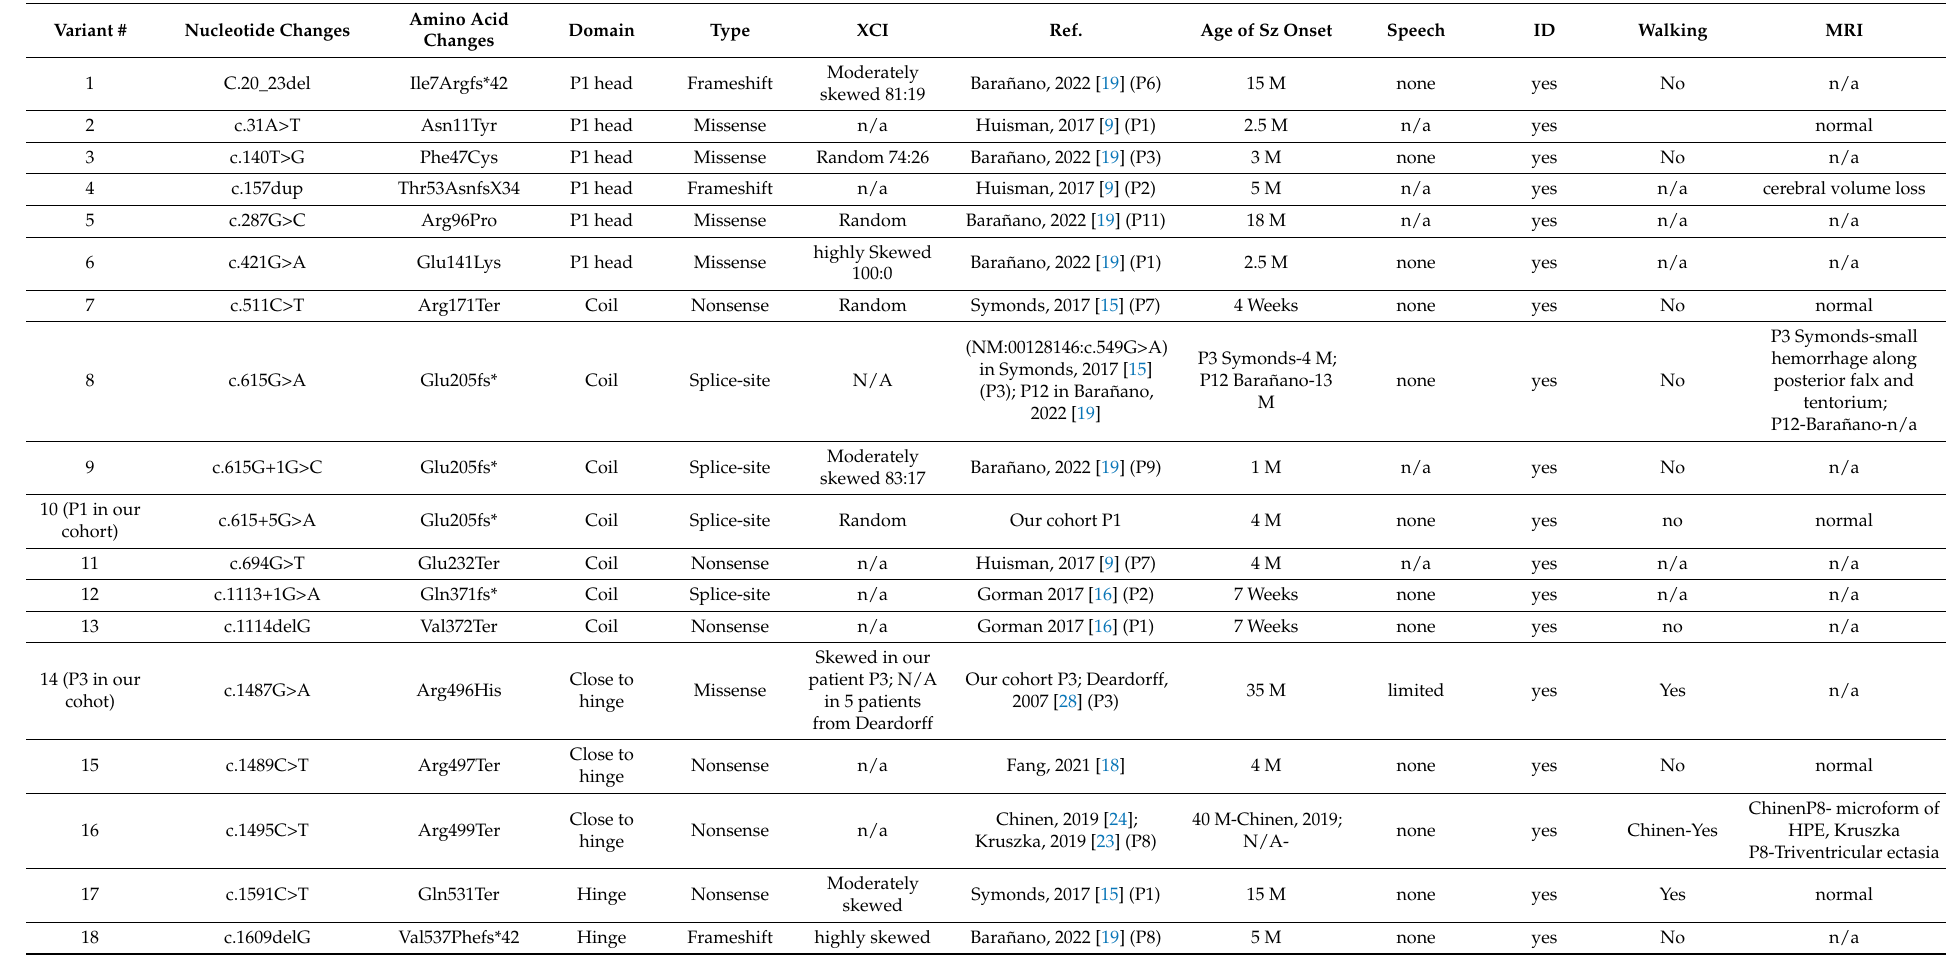
Table 3. Information of 41 SMC1A-DEE